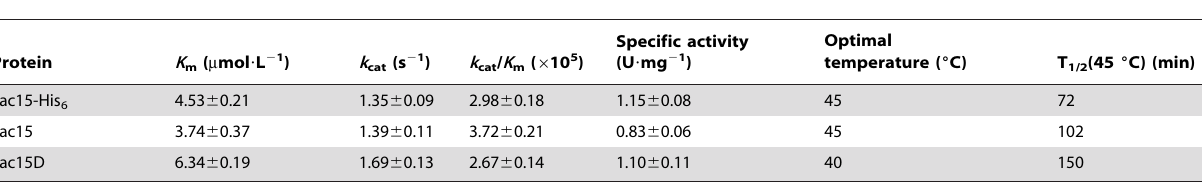
Table 1. Substrate specificity of Lac15, Lac15-His 6 , and Lac15D.